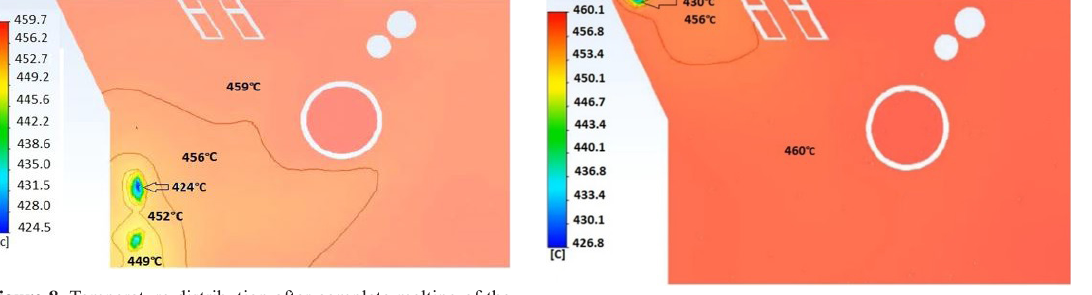
Figure 10. Temperature distribution after melting the 50% ingot inserted into the zinc bath after 7.6 min.